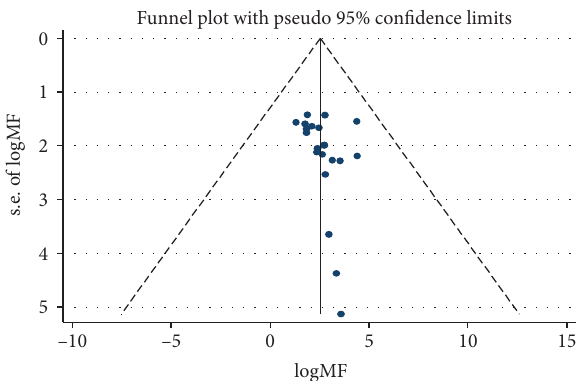
Figure 7: Funnel plot for publication bias for the prevalence of mixed feeding. Table 3: Meta-regression to identify source of heterogeneity for the prevalence of infant feeding practices among HIV-exposed infants in Ethiopia.